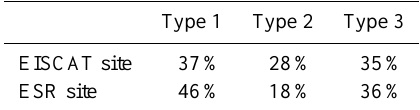
Table 1. Distributions of three types of ELDIs during